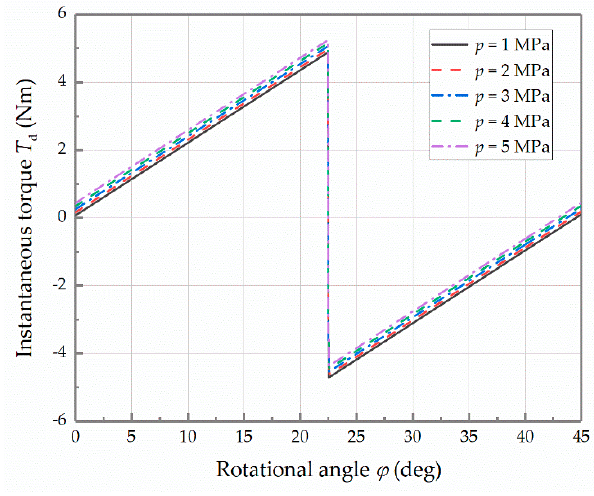
Figure 13. Curves of the instantaneous torque at different pressures.